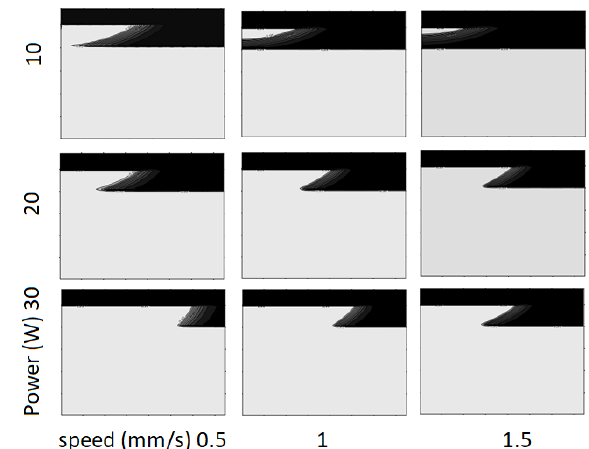
Fig. 3. Principal scheme of laser engraving machine Qualitech 203 mini.